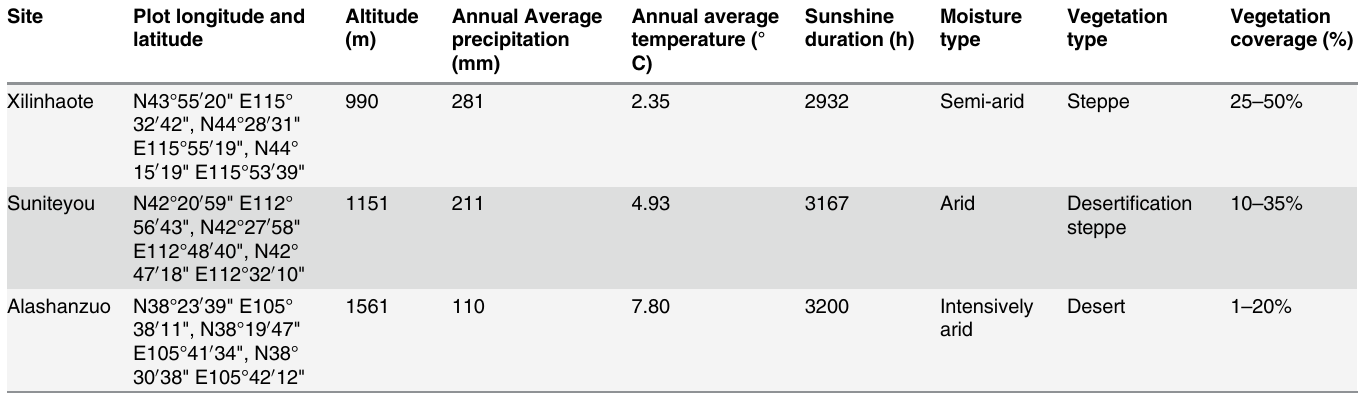
Climate data are the mean values over 40